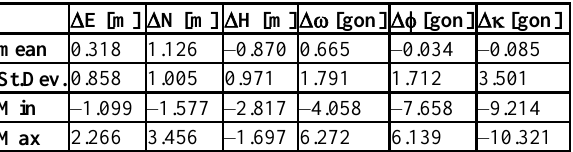
Table 2 Summary of horizontal and vertical